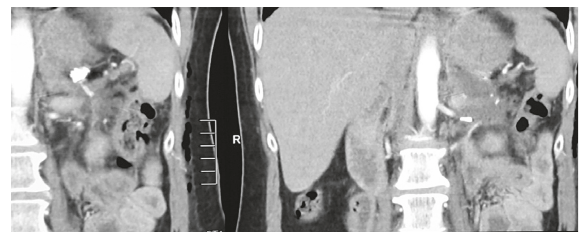
Figure 4: CT angiography performed on the tenth postoperative day showed that there was no splenic